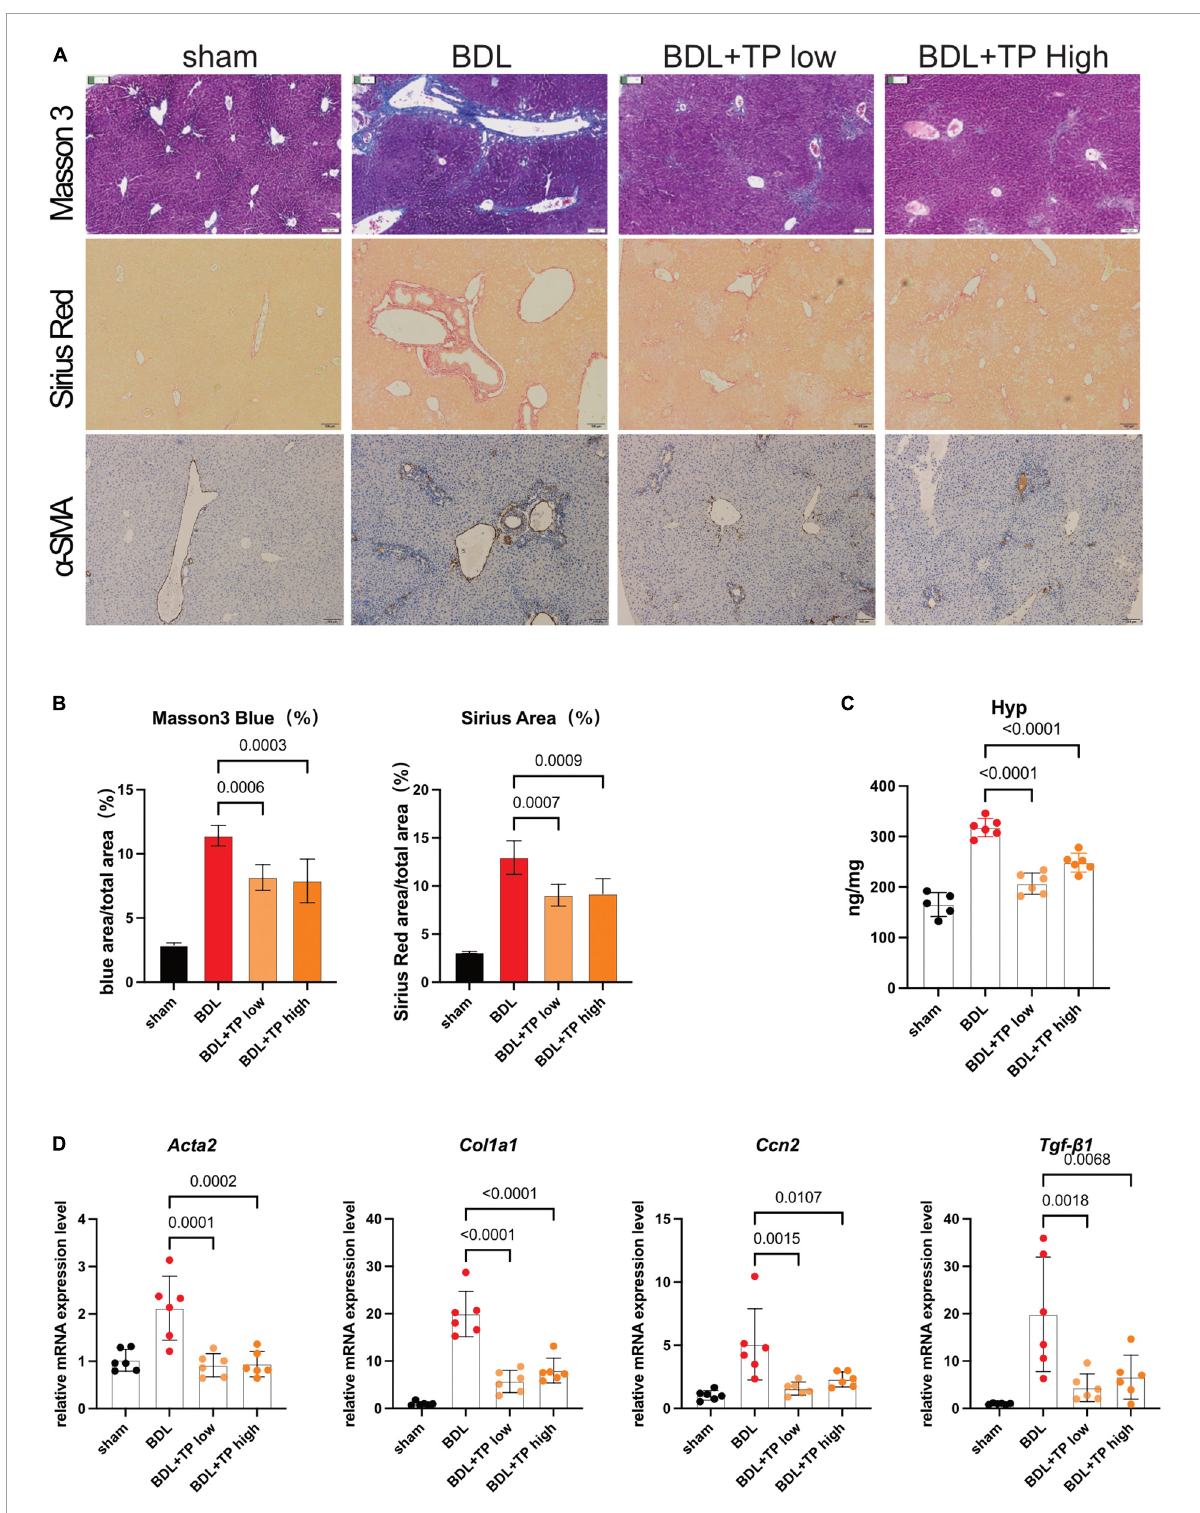
FIGURE5 Triptolide relieves BDL-induced liver fibrosis. (A) Representative images of Masson 3, Sirius Red, and IHC for α -SMA from liver tissues. Scale Bar: 100 µ m. (B) Collagen positive area statistics of Masson3 and Sirius Red. (C) Hydroxyproline assay of liver tissues. (D) The mRNA levels of Acta2 , Col1a1 , Ccn2 , and Tgf- β 1 from liver tissues. Data represent at least 6 independent experiments with triplicate measurements. Analysis of variance (one-way ANOVA) was used. p values represents significance different from BDL